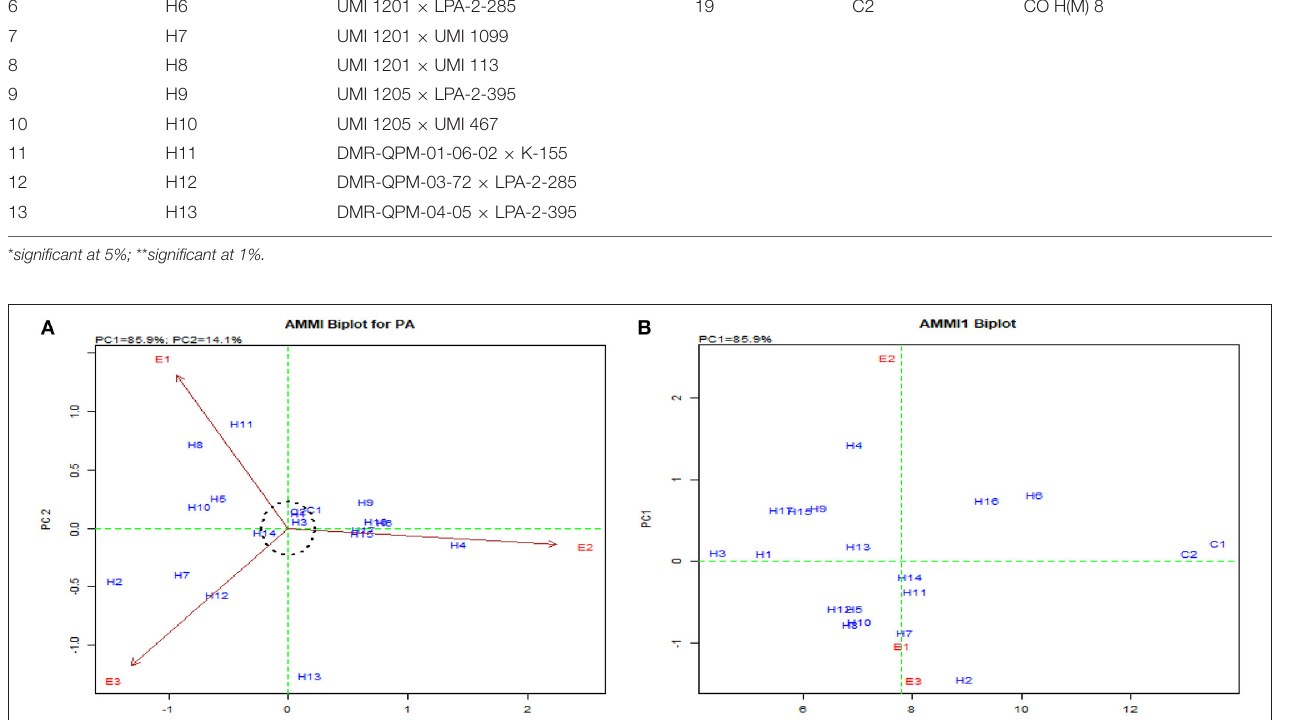
Frontiers in Plant Science |